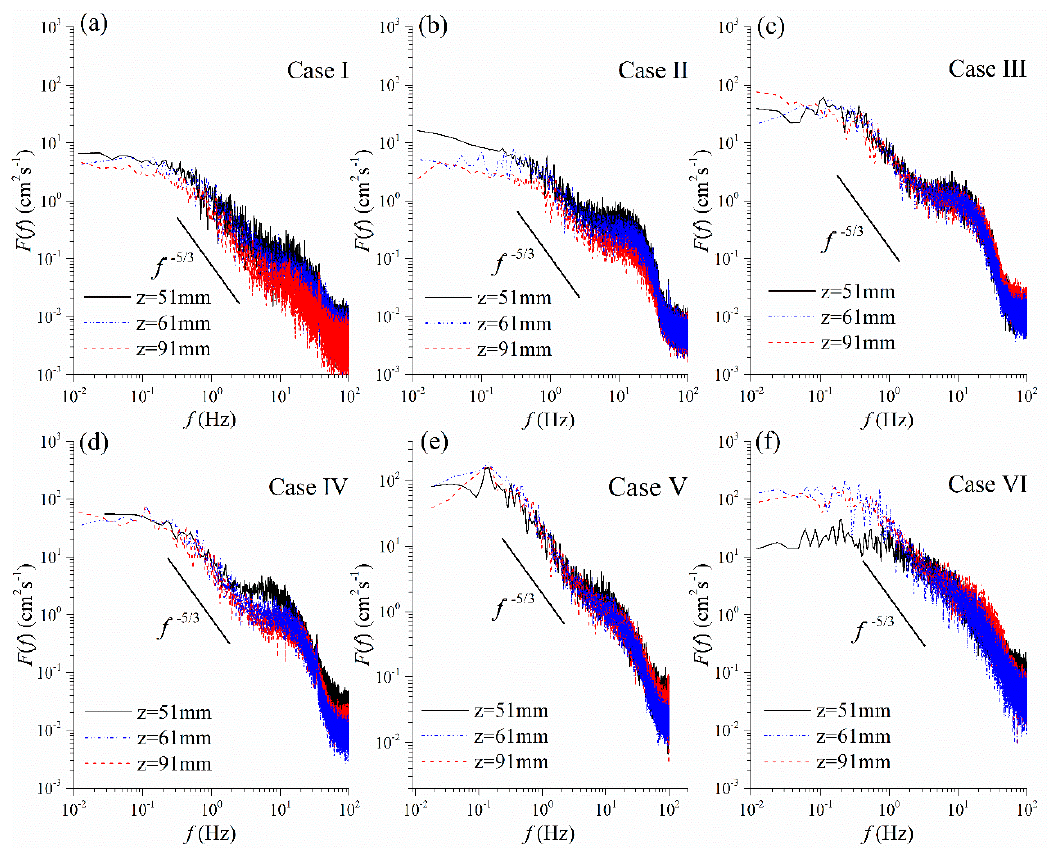
Figure 9. Turbulence spectra F ( f ) at different heights in ( a ) Case I, ( b ) Case II, ( c ) Case III, ( d ) Case IV, ( e ) Case V and ( f ) Case VI.